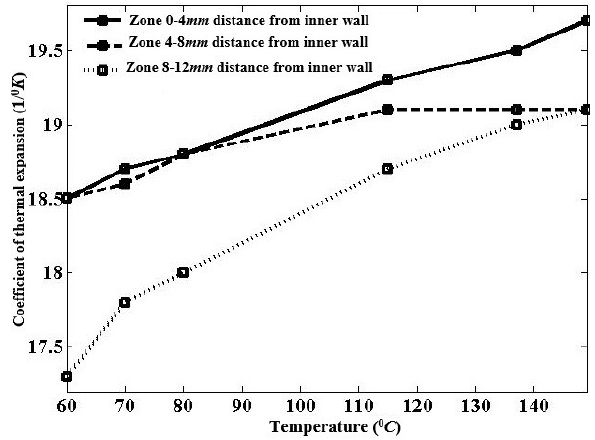
Figure 4: V θ % and V α % distribution of thick FGM cylindrical shell along radial direction from inner to outer walls